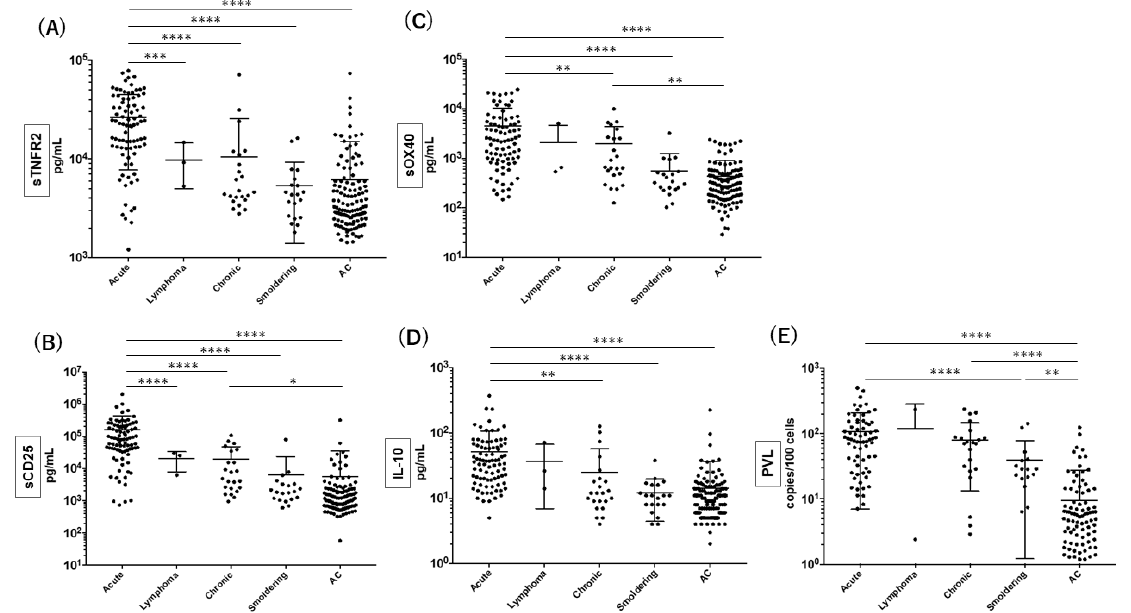
Figure 1. Comparison of plasma sTNFR2, sOX40, sCD25, and IL-10 levels and PVL among different types of ATL and ACs. Sample numbers of ATL and ACs tested were ( A ) 136 and 114, ( B ) 128 and 110, ( C ) 128 and 110, ( D ) 128 and 110, and ( E ) 108 and 113, respectively. **** p < 0.0001, *** p < 0.001, ** p < 0.01, and * p < 0.05.